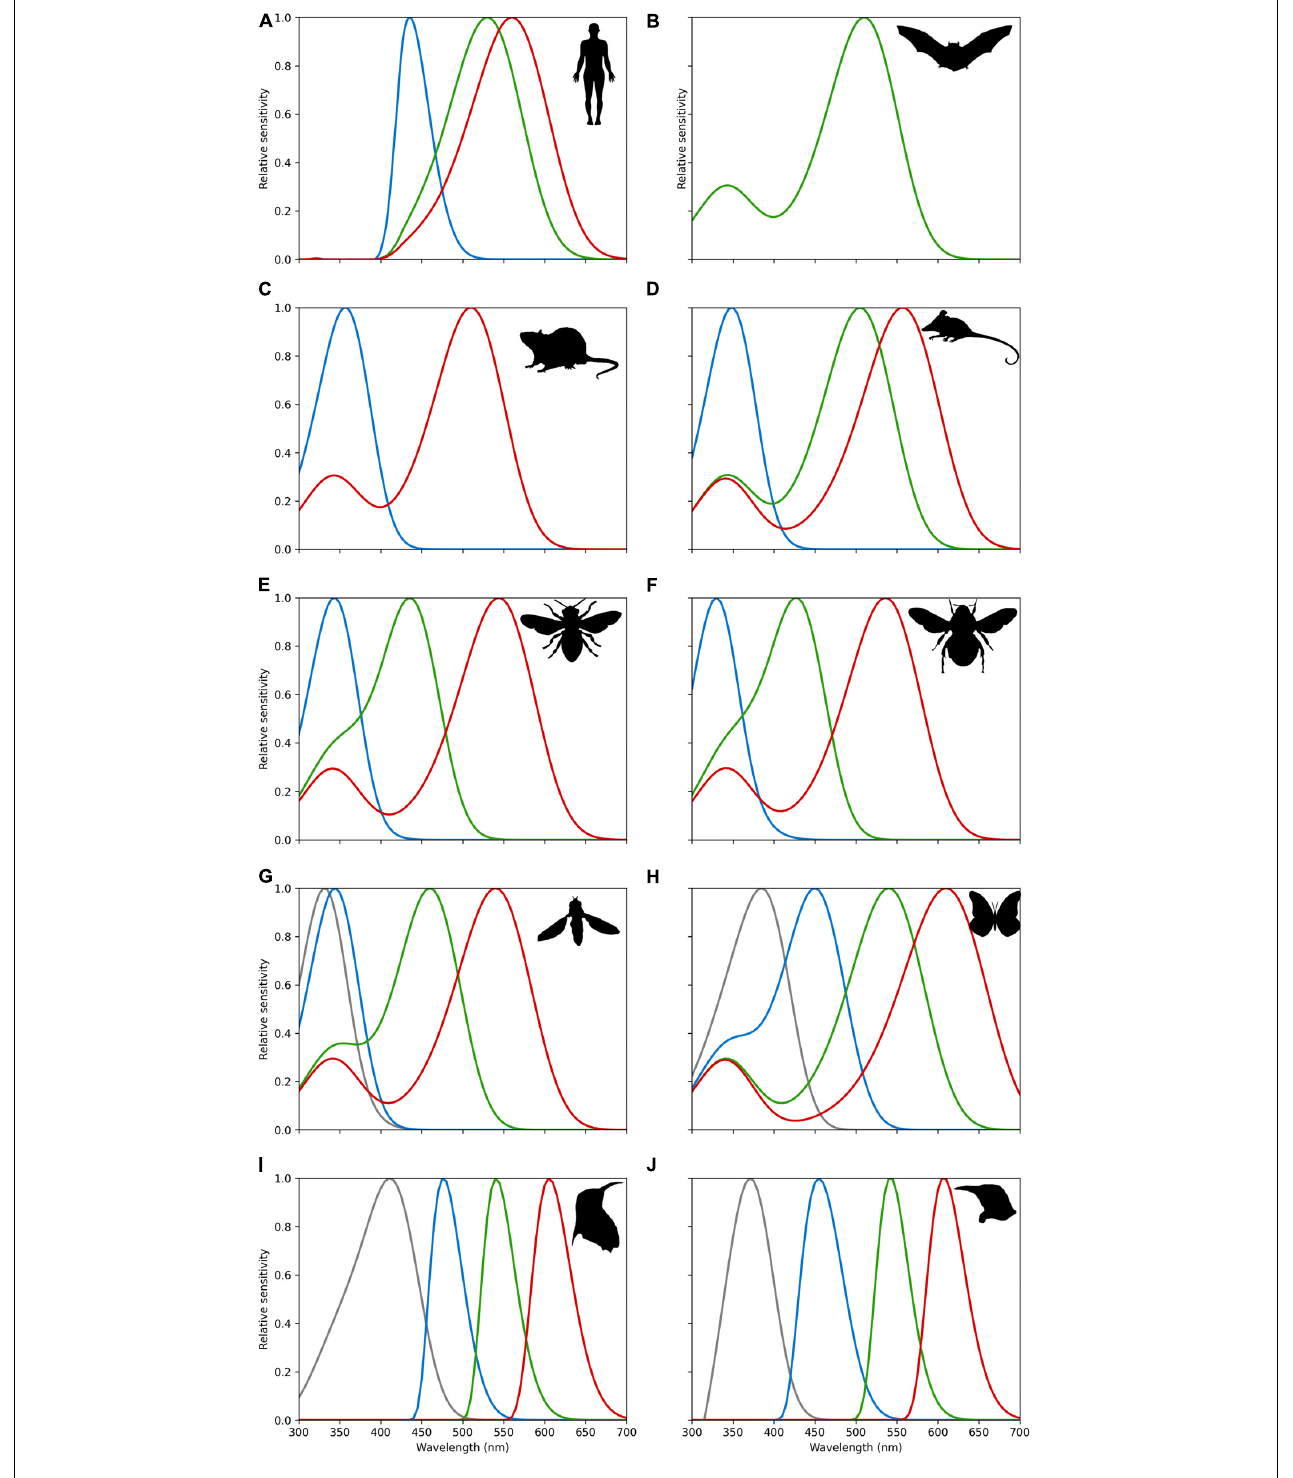
FIGURE 7 | Spectral sensitivities of photoreceptors for (A) Trichromatic humans ( Homo sapiens ) (Dartnall et al., 1983; Stockman and Sharpe, 2000) as a point of comparison, and various animals know to visit flowers; (B) monochromatic flower bat ( Glossophaga soricine ) that senses short wavelength light via a secondary beta-band peak (Winter et al., 2003); (C) dichromatic mouse ( Mus musculus ) (Sun et al., 1997; Wester et al., 2009); (D) trichromatic Australian honey possum ( Tarsipes rostratus ) (Arrese et al., 2002); (E) trichromatic honeybee ( Apis mellifera ) (Peitsch et al., 1992; Briscoe and Chittka, 2001); (F) trichromatic bumble